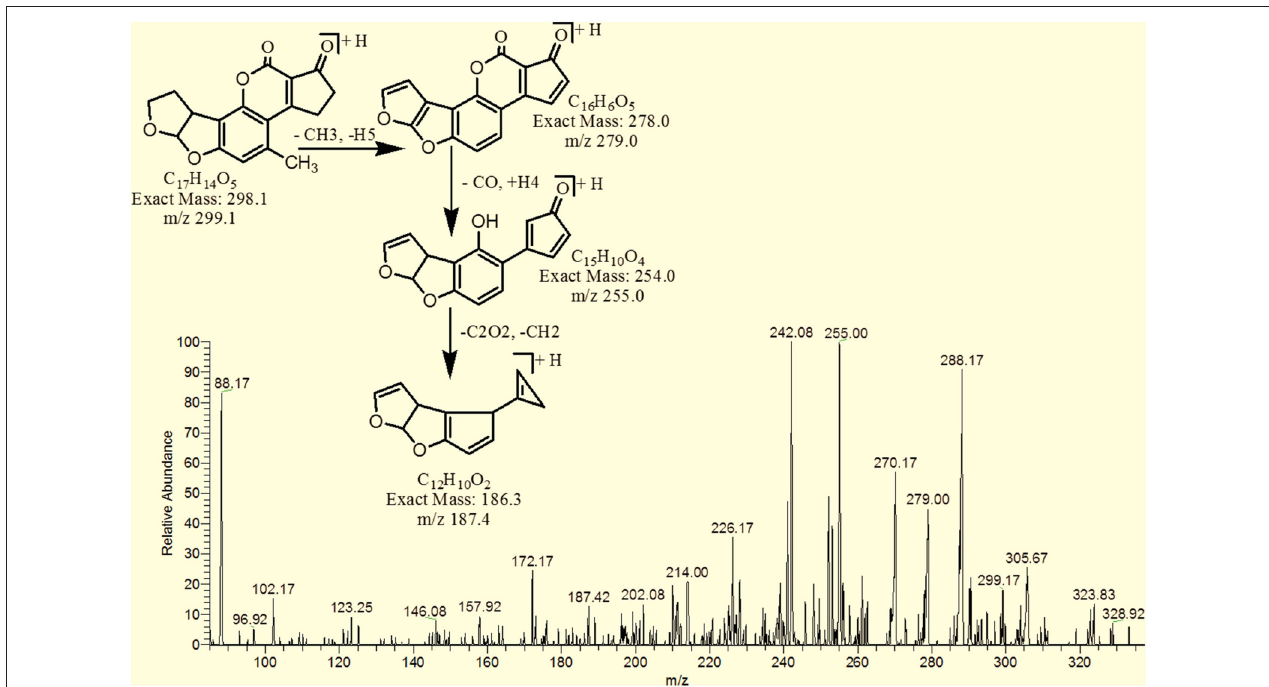
FIGURE 11 | MS/MS spectra and fragmentation pathway of degradation product with 299.17m/z.